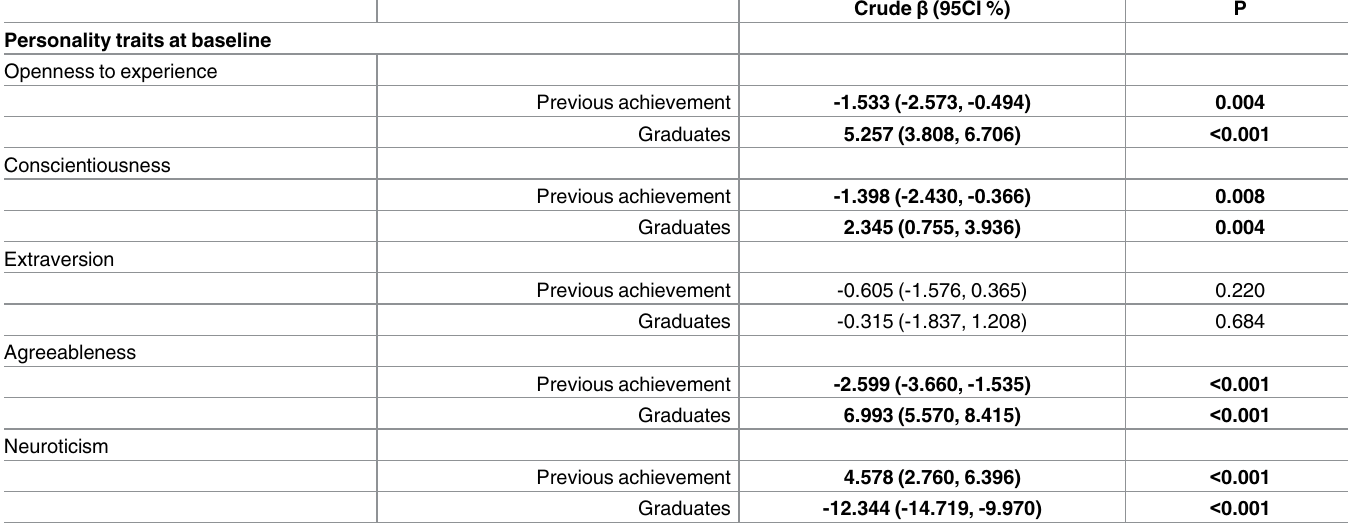
Table 1. Cross-sectional association between personality traits and previous achievement at